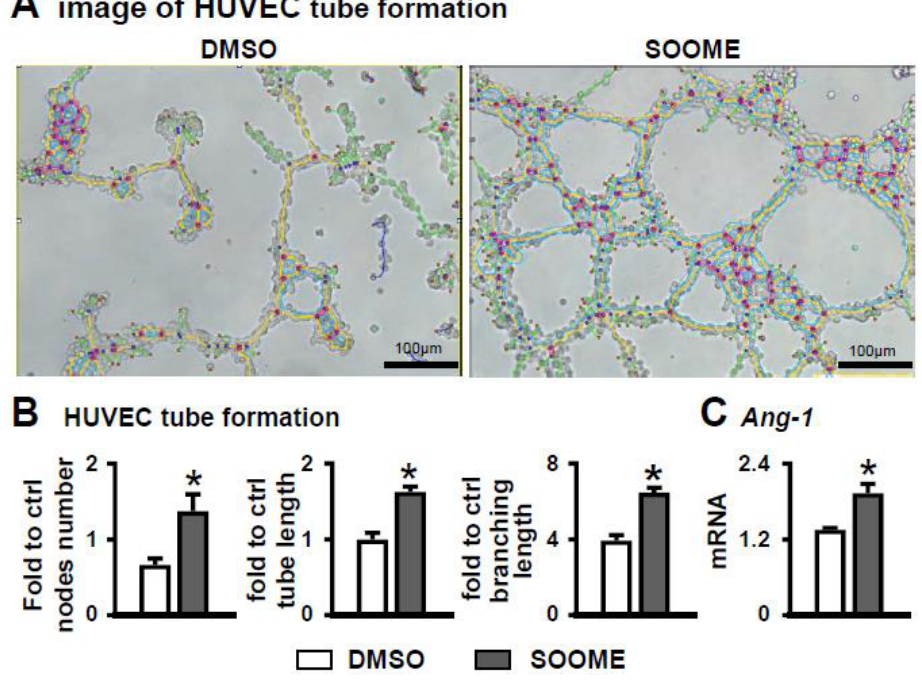
Figure 5. Effects of SOOME in PCI3D modules on osteoblast differentiation and mineralization of stromal cells. Wnt-activated MLO-Y4 promoted osteogenic differentiation of stromal cells in PCI3D modules with SOOME and ST2 cells. After being cultured for 7 and 14 days, the cells were subjected to ( A ) AP staining; ( B ) AP activity assays; and ( C ) qPCR for the expression of osteoblast marker genes. ( D , E ) Increased mineralization of the PCI3D modules. Modules were cultured in full growth medium for 7 days, followed by culture in the osteogenic medium supplemented with ascorbic acid, β -glycerophosphate disodium and dexamethasone. Alizarin red S staining revealed denser formed bone nodules in SOOME 3D modules. The * symbol indicates p < 0.05 versus DMSO control; n = 3. Scale bar = 200 µ m. Ct, cycle number detected by qPCR machine for a relative amount of target genes.